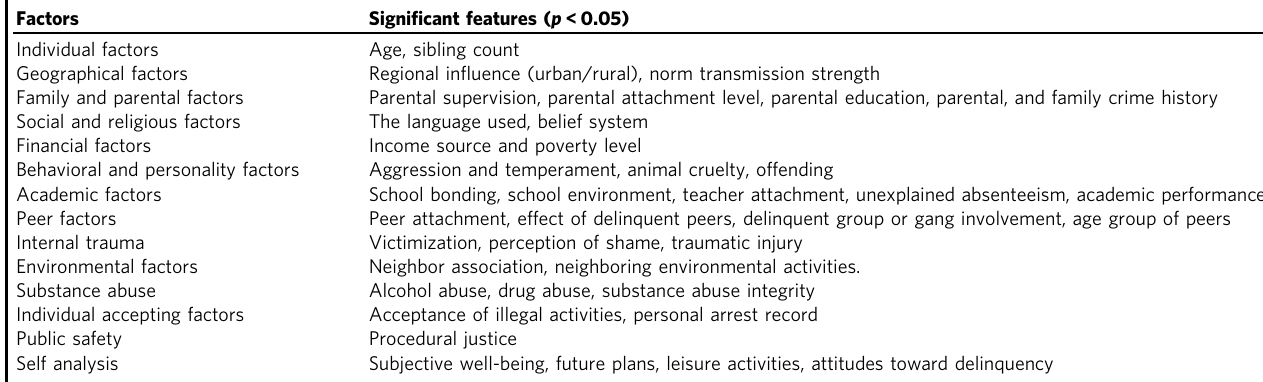
Table 1 Signi fi cant socio-demographic risk factors and predictors for juvenile delinquency detection and classi fi cation. Factors Signi fi cant features ( p < 0.05)